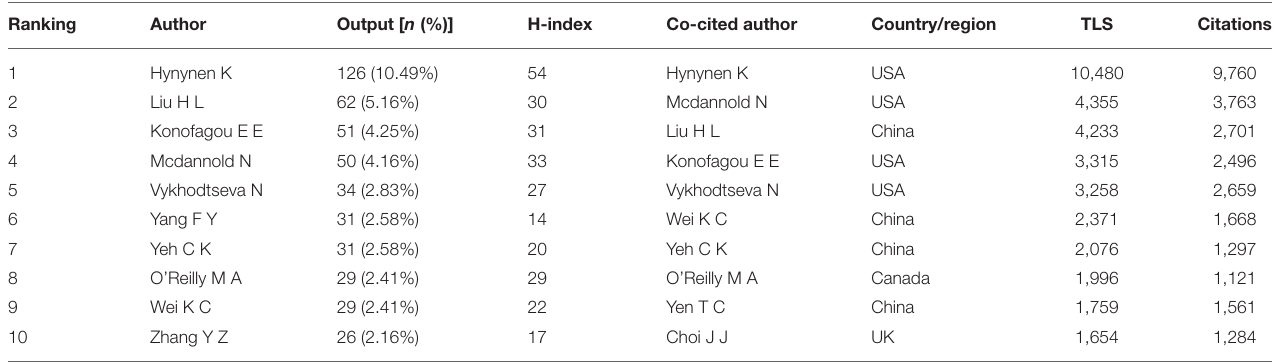
TABLE 3 | The top 10 productive and most co-cited authors in ultrasound-induced BBB opening